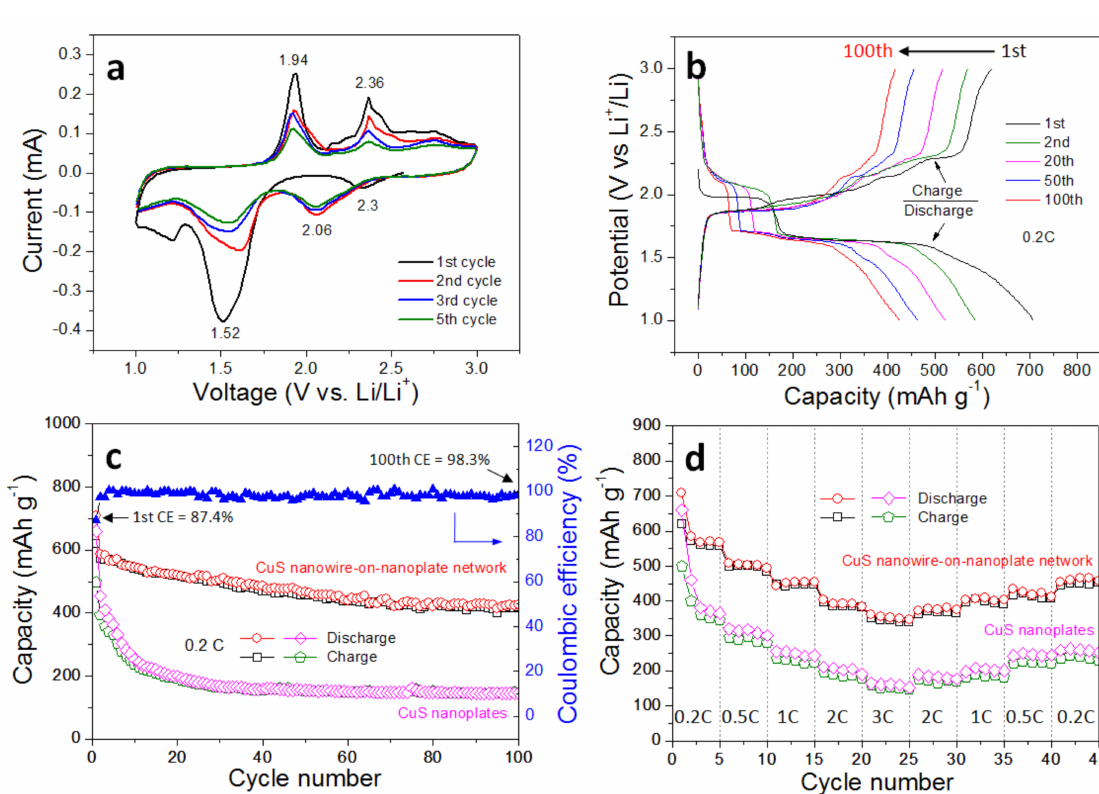
Figure 5. Electrochemical characterization of CuS anodes: ( a ) CV curves, ( b ) Charge/discharge curves at 0.2 C, ( c ) Cycling performance and coulombic efficiency, and ( d ) Rate